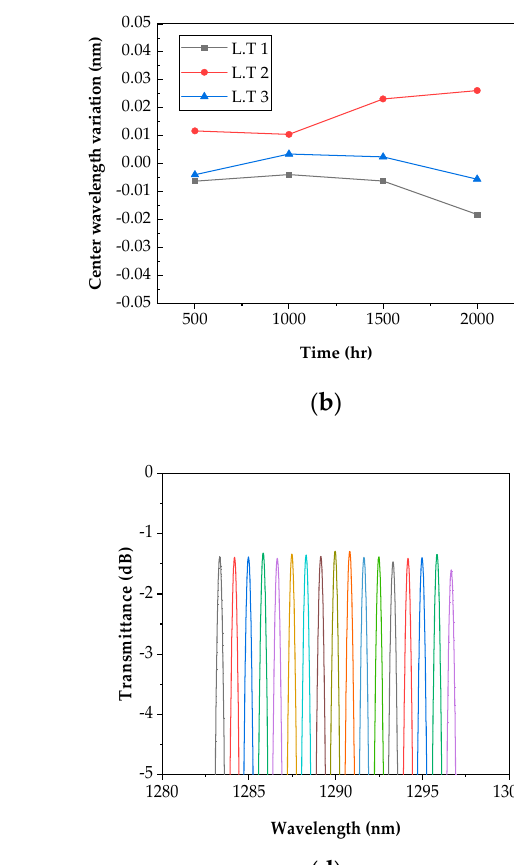
testing (L.T.); ( a ) IL deviation; ( b ) C.W. shift; ( c ) Spectrum (L. T. 1); ( d ) Zoom in spectrum around 0